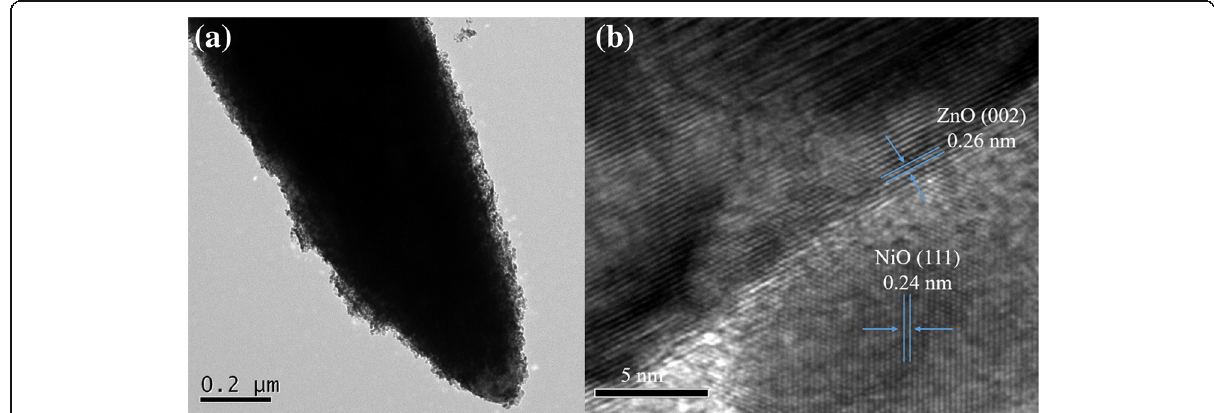
Fig. 5 a TEM image of ZnO@NiO heterostructure (ZN2). b High-resolution TEM of the image of